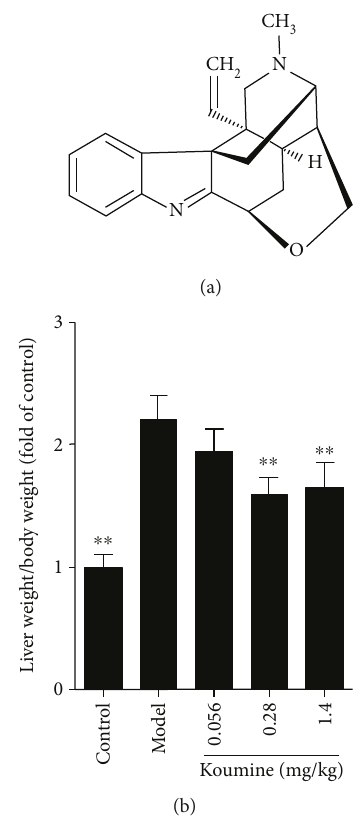
Figure 1: Chemical structures of koumine (a) and the e ff ect of koumine on the liver index of NAFLD rats induced by fat diet. ∗∗ p < 0 01 versus the model